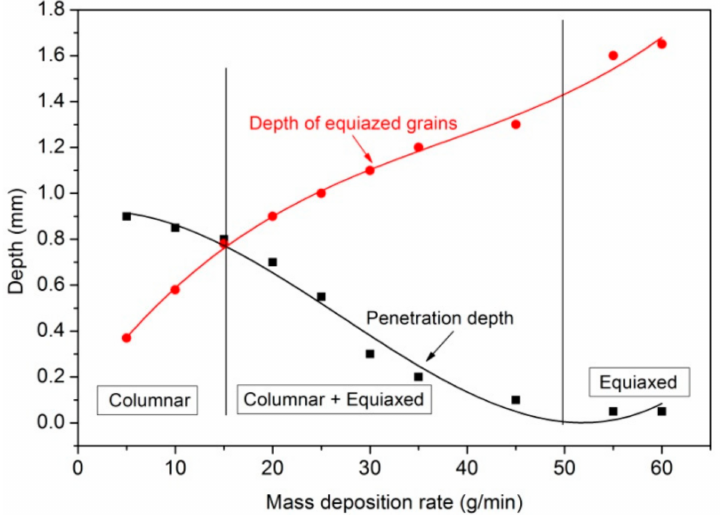
Figure 6. Depth of equiaxed grains zone d EG and penetration melting depth d PM as a function of mass deposition rate for the single-track laser deposited specimens (reproduced with permission from [87] Copyright Elsevier, 2015).